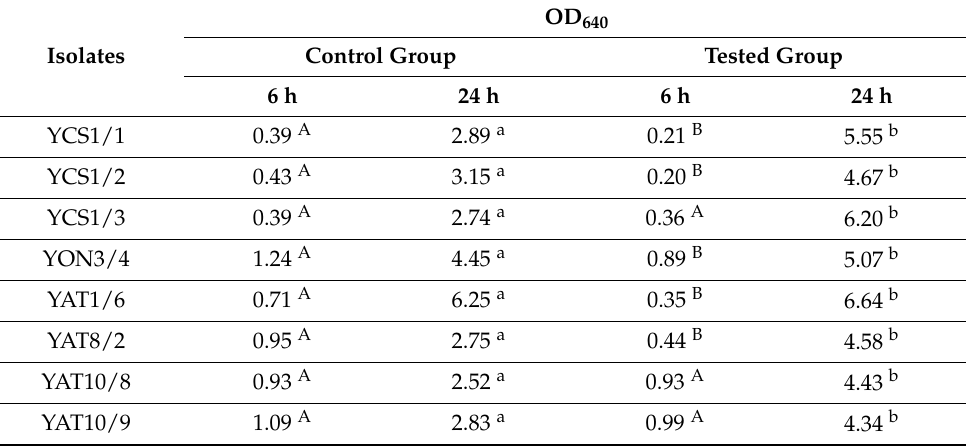
Table 2. Effect of bile salt on the growth of some yeast isolates. The uppercase letters show the comparison of the OD 640 value of each isolate in the tested and control group at an incubation period of 6 h; the lowercase letters show the comparison of the OD 640 value of each isolate in the tested and control group at 24 h of incubation; different letters in each column show a statistically significant